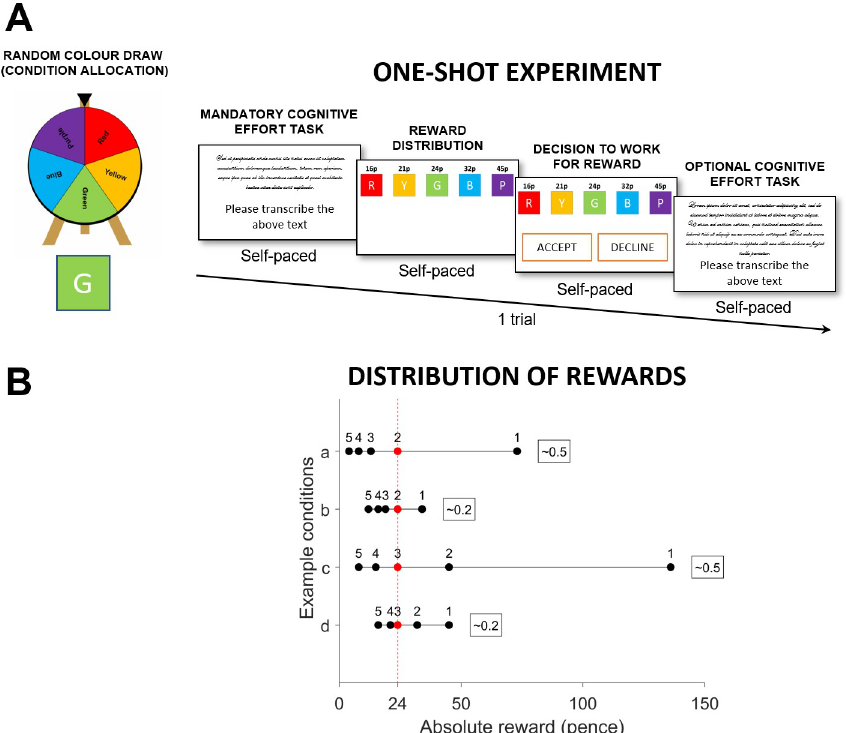
Fig 1. Behavioural task in Experiment 1. (A) The online task had a one-shot design. The task was advertised on an online labour market platform as a simple transcribing job. After completing the mandatory cognitive task, participants were informed that they would have an opportunity to complete an optional transcribing task for a randomly drawn fee. The random draw was determined by spinning a wheel of fortune that assigned a participant one out of five different colours. After the colour assignment, participants were presented with the reward offers for all five colours, and were told that the other rewards were assigned to other people who drew those colours. Participants then decided to either accept or decline the reward offer for the optional task. If they accepted it, they had to transcribe an additional text. If they declined it, the task ended, and they were granted their base fee. Unbeknownst to participants, the reward offer was always equal to £0.24, and the random colour assignment determined if the offer was presented either as 5 th , 4 th , 3 rd , 2 nd or 1 st best reward. Independently, participants were randomly assigned to one of two levels of unfairness (Gini coefficient = 0.3 or Gini coefficient = 0.5) of reward distribution. (B) The task had a 5x2 design (10 conditions in total): two levels of inequality, and five levels of relative value. Each participant viewed only one of these conditions. Panel B illustrates example conditions. The example a) shows a situation where £0.24 was presented as the second-best reward in an unfair context, and example b) where it was presented as the second-best reward in a fair context. The example c) shows a situation where £0.24 was presented as the middle reward in an unfair context, and the example d) shows a situation where £0.24 was presented as the middle reward in a fair